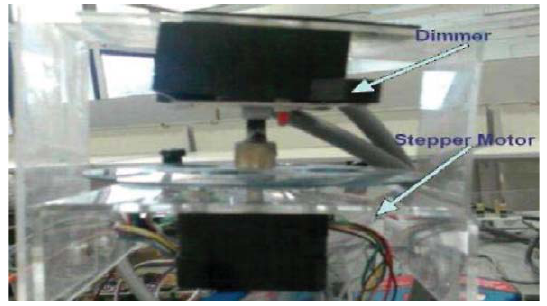
Fig. 4. Dimmer mounted on the stepper motor for fan speed